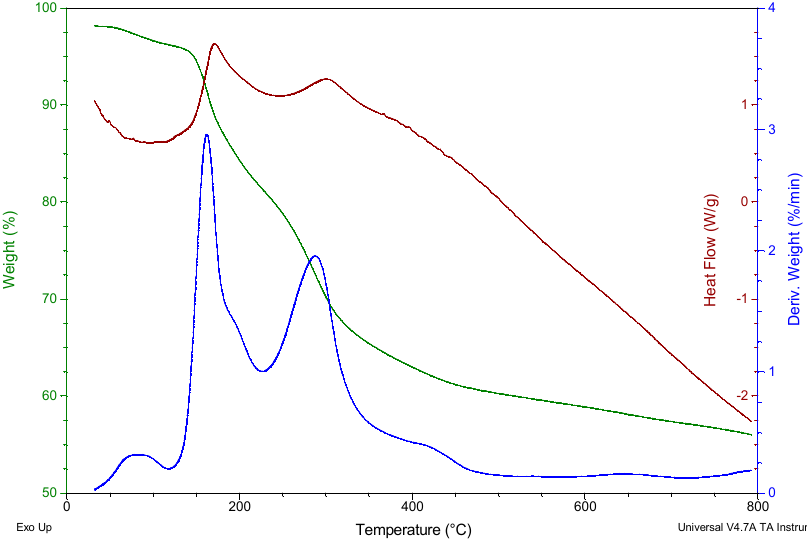
Figure 4. TG/DTG and DSC curves of the CA-AgNPs obtained in nitrogen atmosphere.